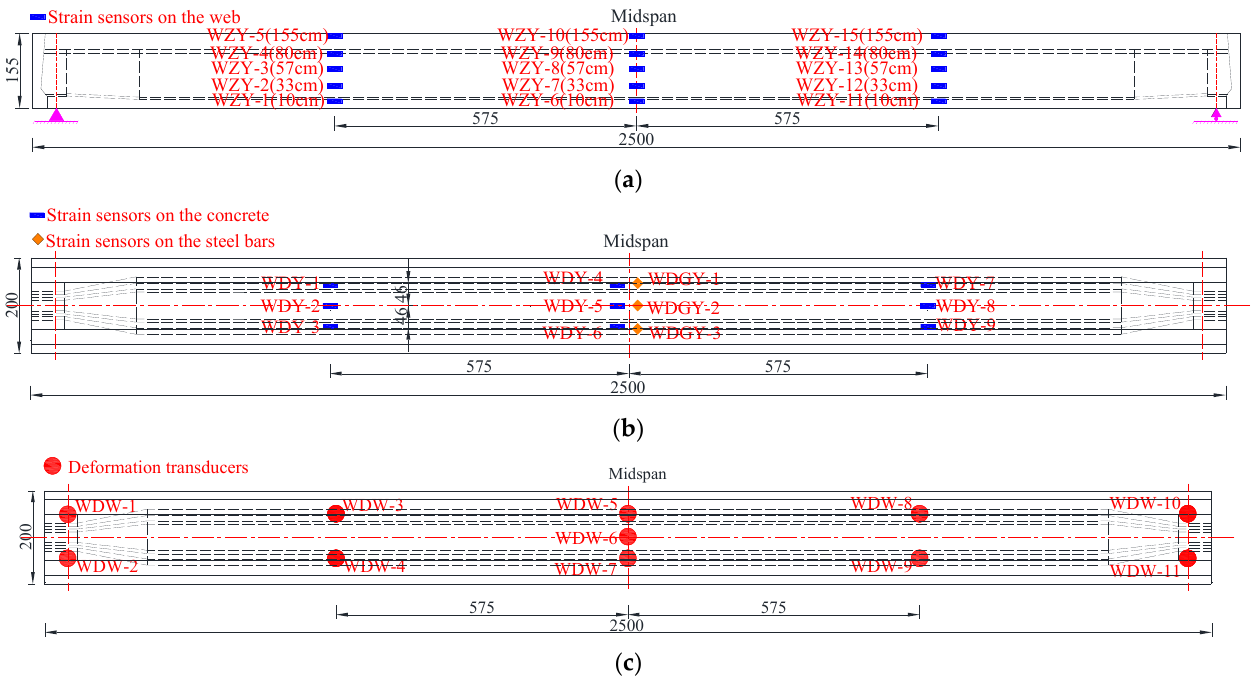
Figure 8. Sensor arrangement for the destructive test of the undamaged box girder (Unit: cm). ( a ) Strain sensor arrangement at the concrete web; ( b ) Strain sensor arrangement at the concrete floor and steel bars; ( c ) Deformation sensor arrangement at the bottom of the girder. Table 3. Test equipment.